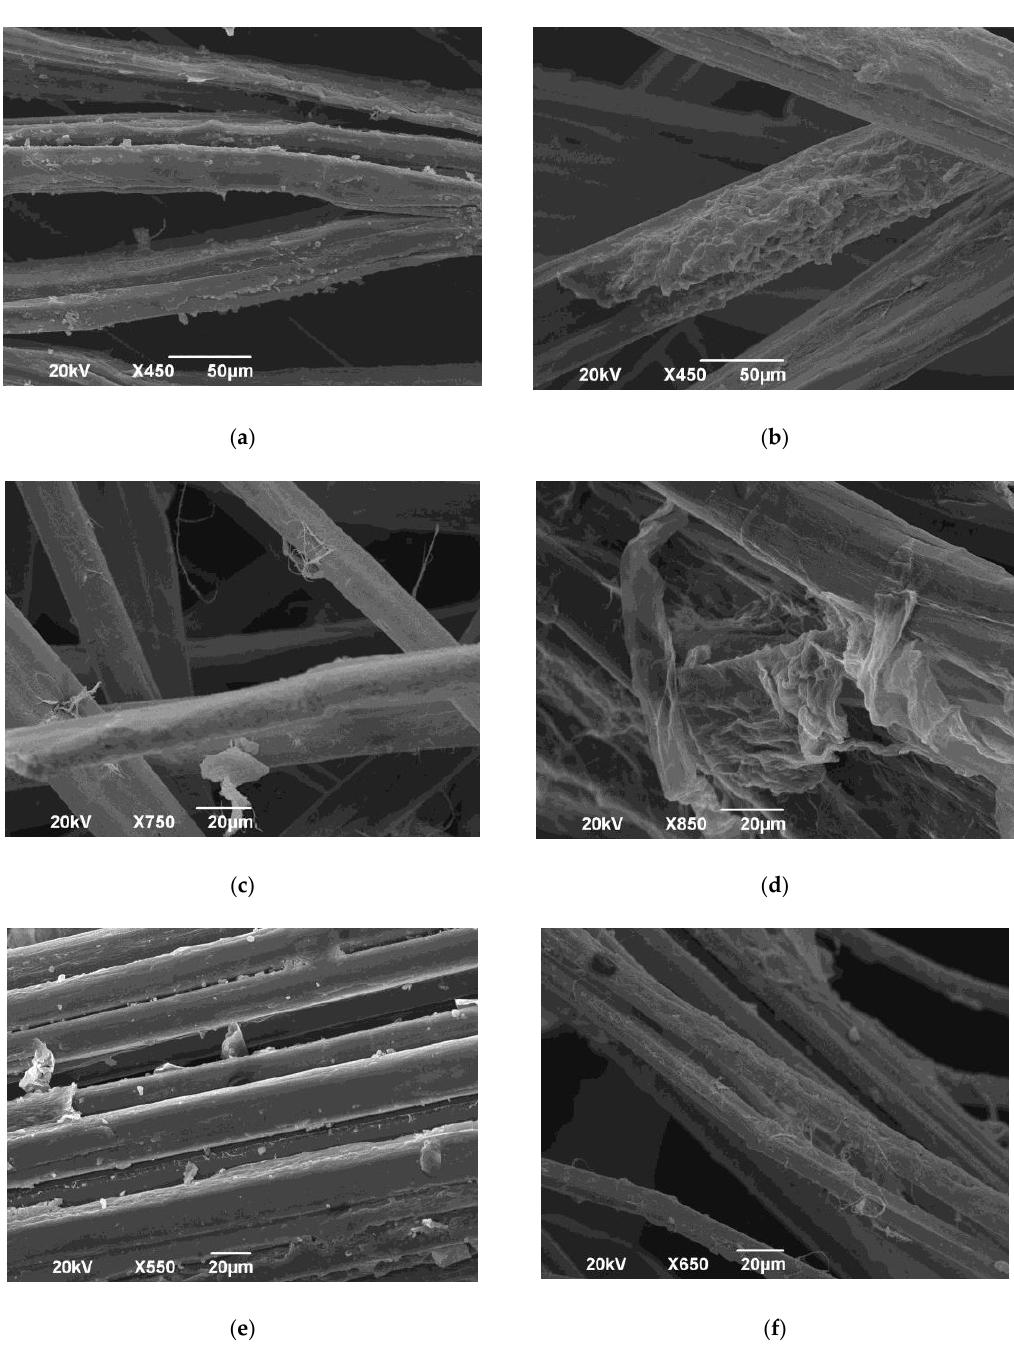
Figure 1. SEM images of ( a ) kenaf fiber, ( b ) BY37-kenaf, ( c ) ramie fiber, ( d ) BY37-ramie, ( e ) flax fiber, and ( f ) BY37-flax.